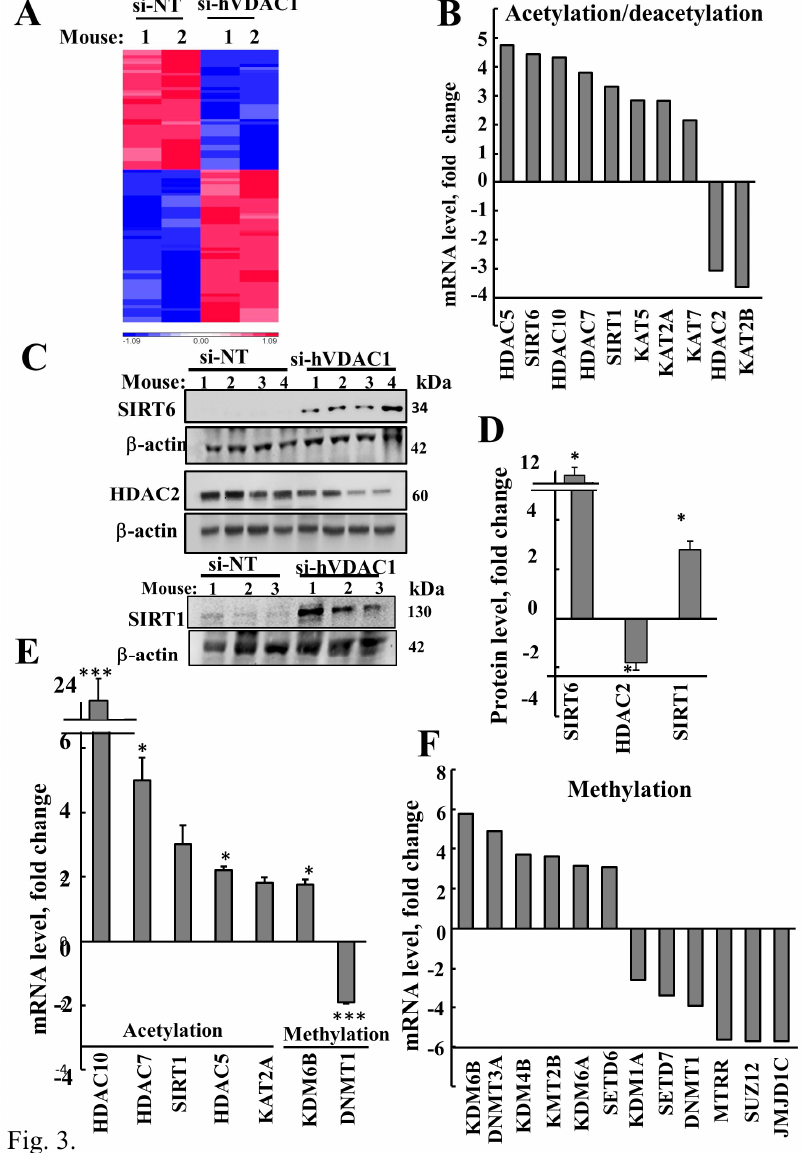
Figure 3. VDAC1 depletion altered the expression of epigenetics-related genes and proteins. ( A ) Hierarchical clustering of selected epigenetics-related genes (95) which were significantly up- or down-regulated in si-hVDAC1-TTs, relative to si-NT-TTs (FDR-adjusted p -value < 0.05 and linear fold change of decreased or increased expression > 2). The color scale of the standardized expression values is shown. ( B ) Fold change of genes associated with histone acetylation/deacetylation (selected from DNA microarray data, Tables 1 and 2). Immunoblotting of the acetylation-related enzymes SIRT6, HDAC2, and SIRT1 using specific antibodies (C) and quantification of the blots (D) . ( E ) DNA microarray analysis of up- or down-regulated methylation-related genes in si-hVDAC1-TTs, relative to si-NT. ( F ) mRNA levels of selected proteins from ( B ) and ( E ) were validated by qRT-PCR using specific primers . Results show means ± SEM ( n = 3). p < 0.001 (***), p < 0.05 (*).